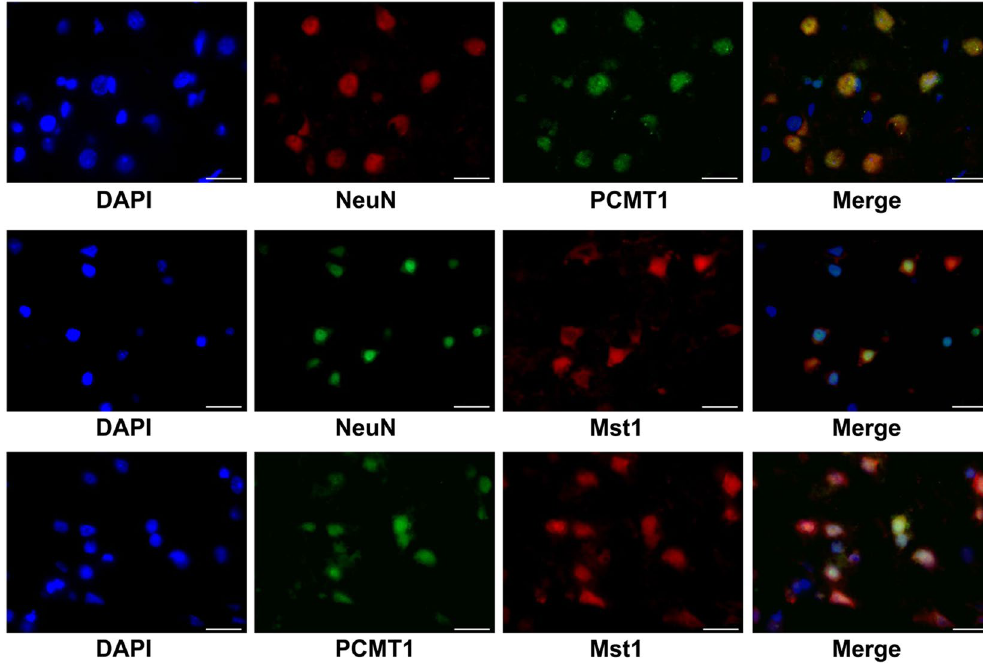
Figure 2. Double fluorescence labeling of PCMT1/Mst1/Neuron in peri-injured cortex at 24 h after TBI. PCMT1 and Mst1 were both co-located and highly expressed in the neurons. Scale bar = 20 μ m.